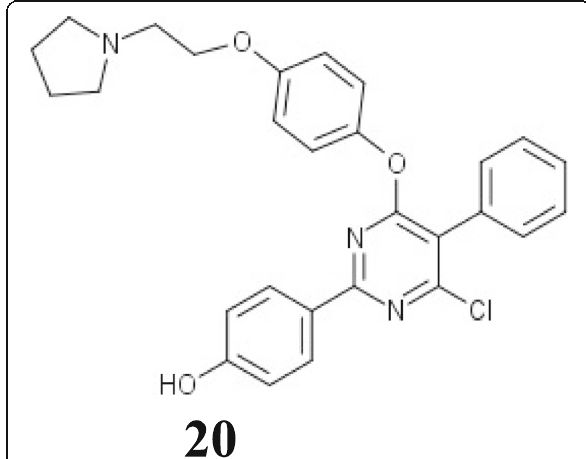
Fig. 7 Chemical structure of tetrasubstituted pyrimidines